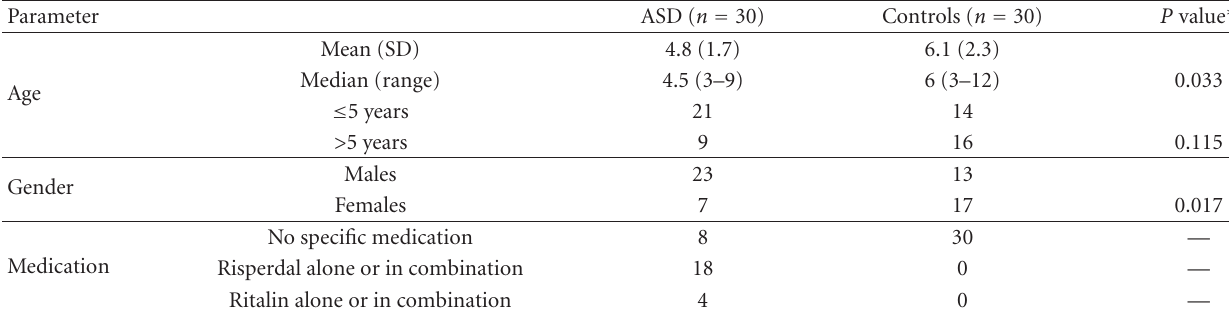
∗ Di ff erence between ASD and controls. Mann-Whitney U -test for age and Fisher’s exact test for age category and gender.